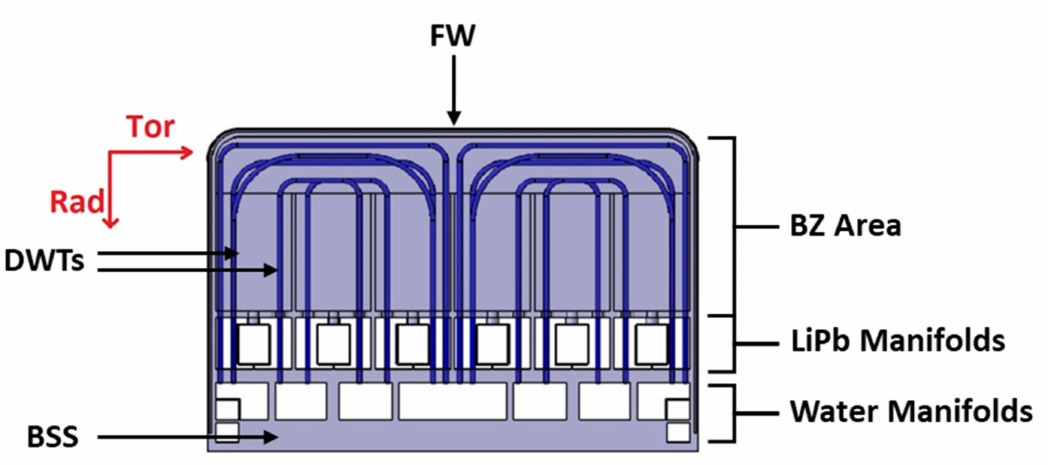
Figure 2. EU-DEMO Water Cooled Lithium-Lead (WCLL) blanket component: detail of the Central Outboard (COB) equatorial breeding cell, WCLL2018.v0.6 design